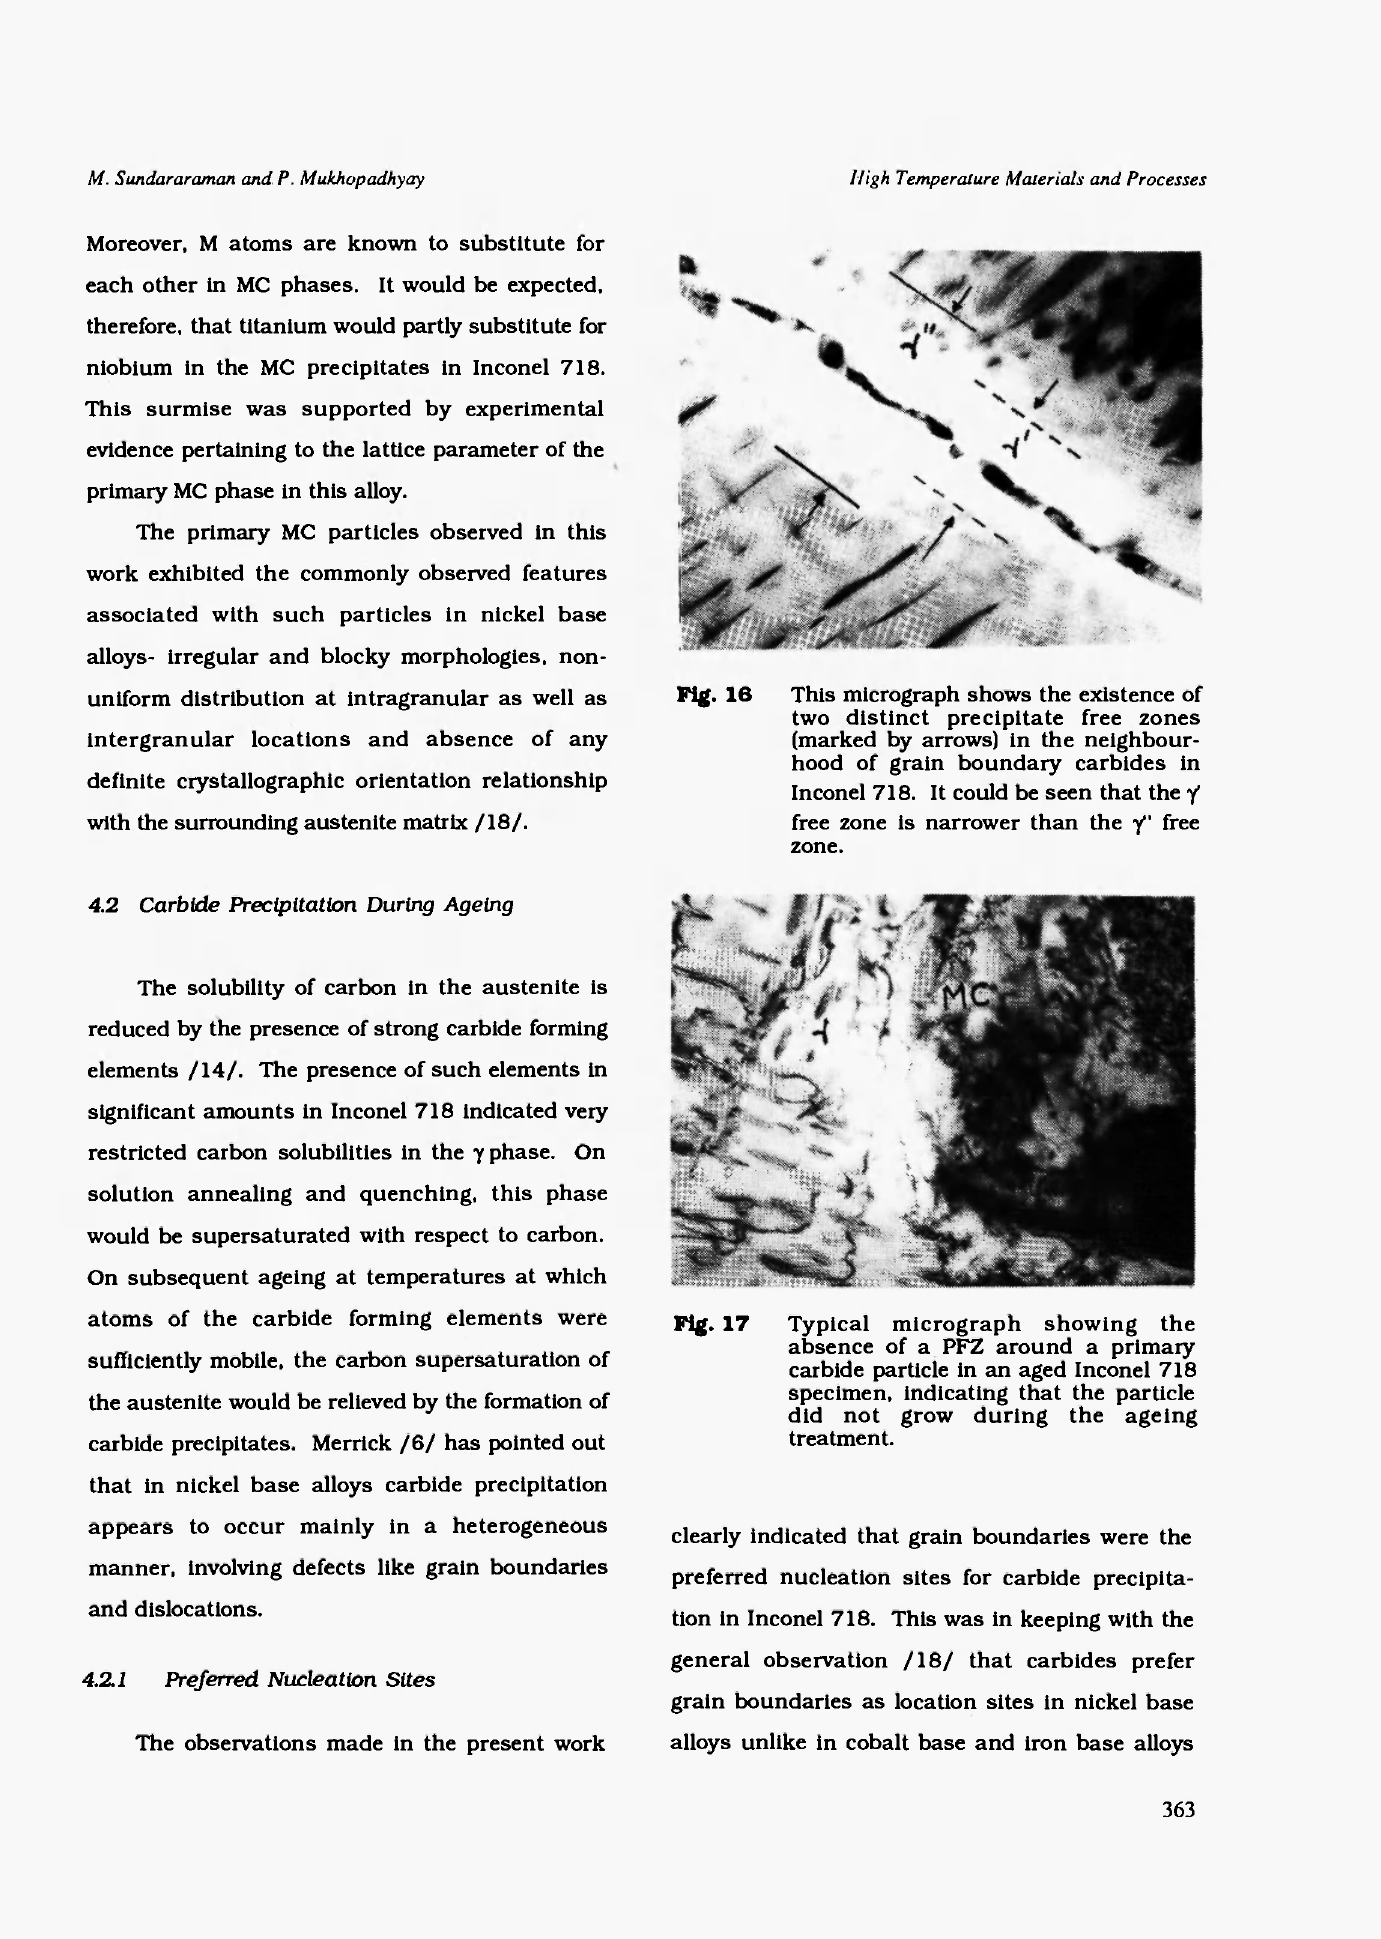
Fig. 17 Typical micrograph showing the absence of a PFZ around a primary carbide particle in an aged Inconel 718 specimen, indicating that the particle did not grow during the ageing